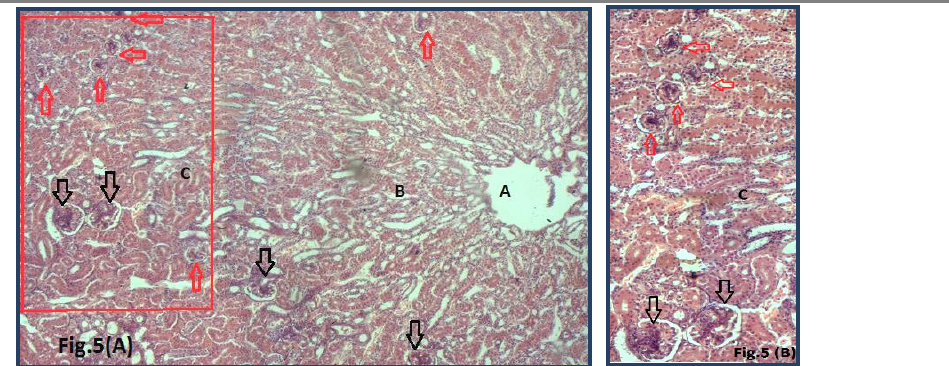
Figure,7: Histological section of mallard kidneys: (A) show: (A) Central vein. (B) Medulla. (C) Cortex. (Black arrows how mammalian glomeruli-Red arrows show reptilian type H&E stain 100x. (B) is magnifying of red box in left figure 400